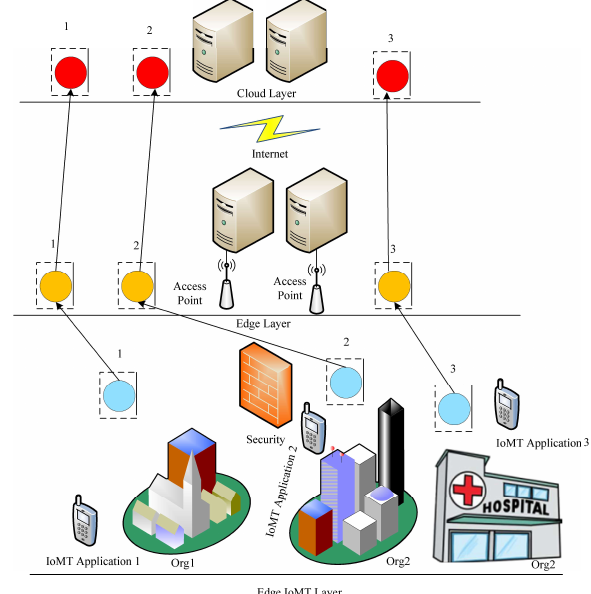
Figure 2. IoMT system model.